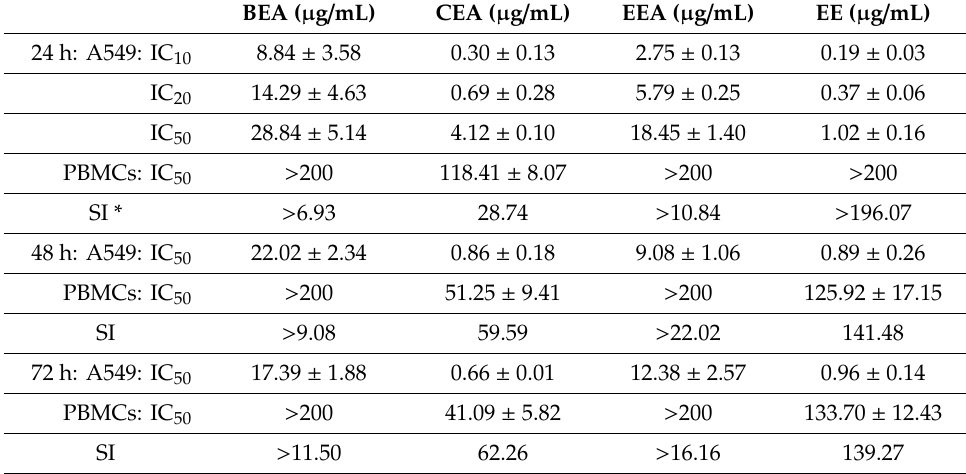
Table 1. The IC values of the e ff ective extracts at 24-, 48-, and 72-h incubation time against A549 cells and PBMCs, and SI of each